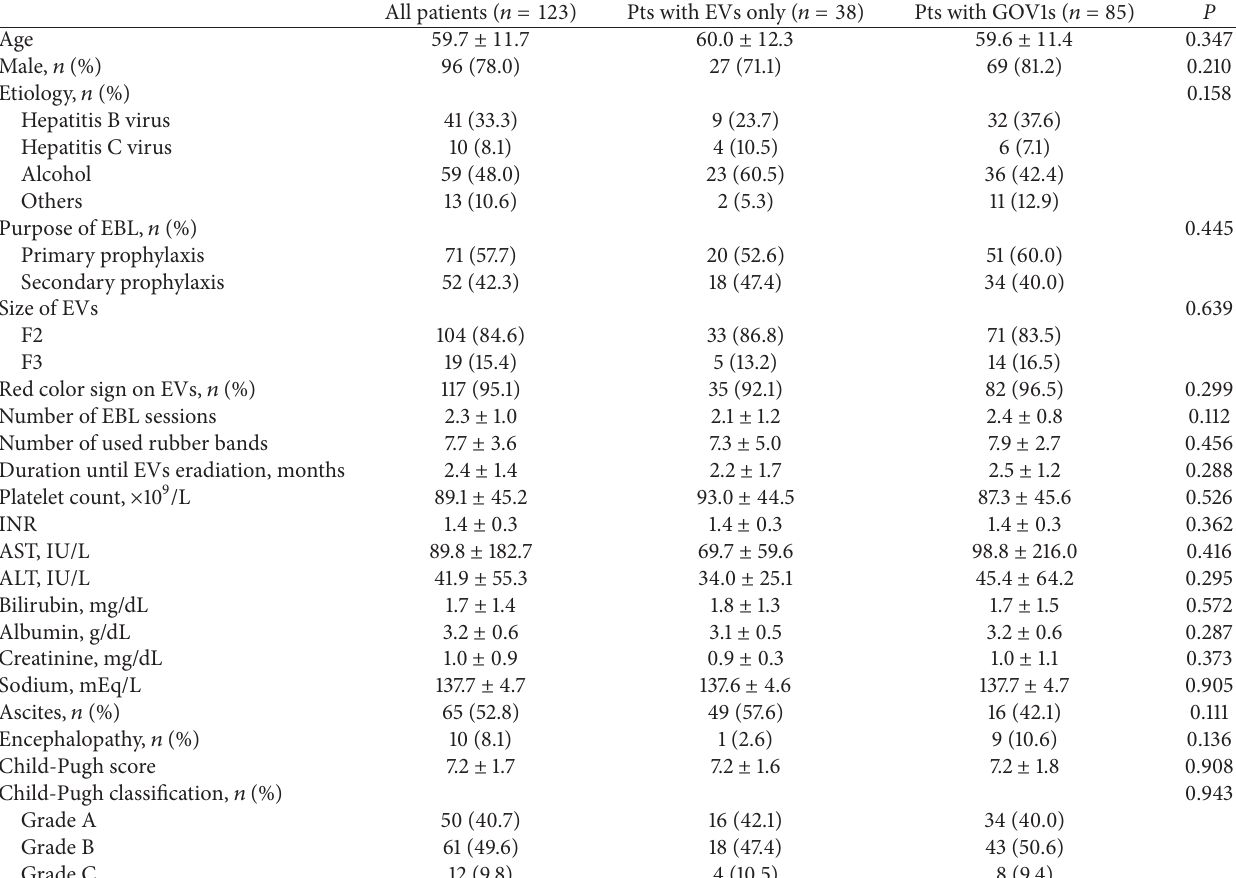
Table 1: Baseline characteristics of patients who underwent EVs eradication by EBL—arranged according to the type of